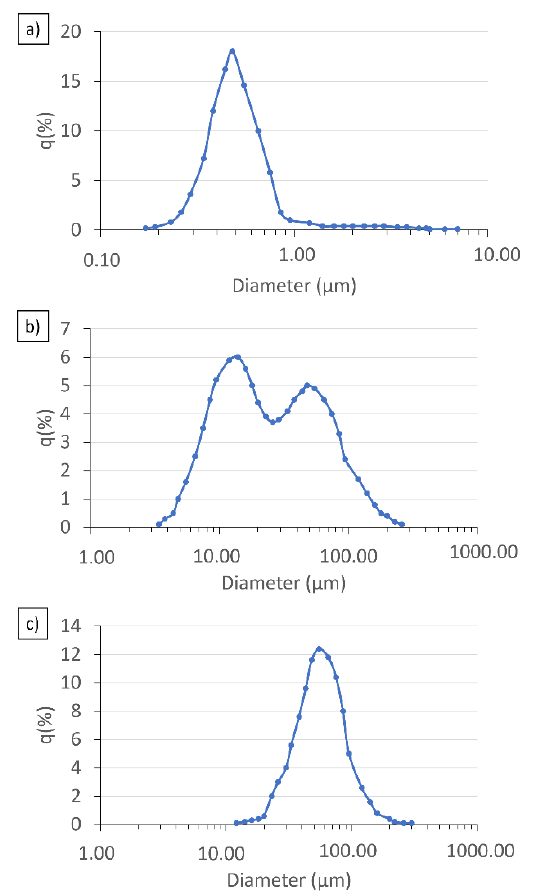
Figure 3. Results generated for aluminum ( a ), nickel ( b ) and titanium ( c ) oxide powders by dynamic light scattering. 303